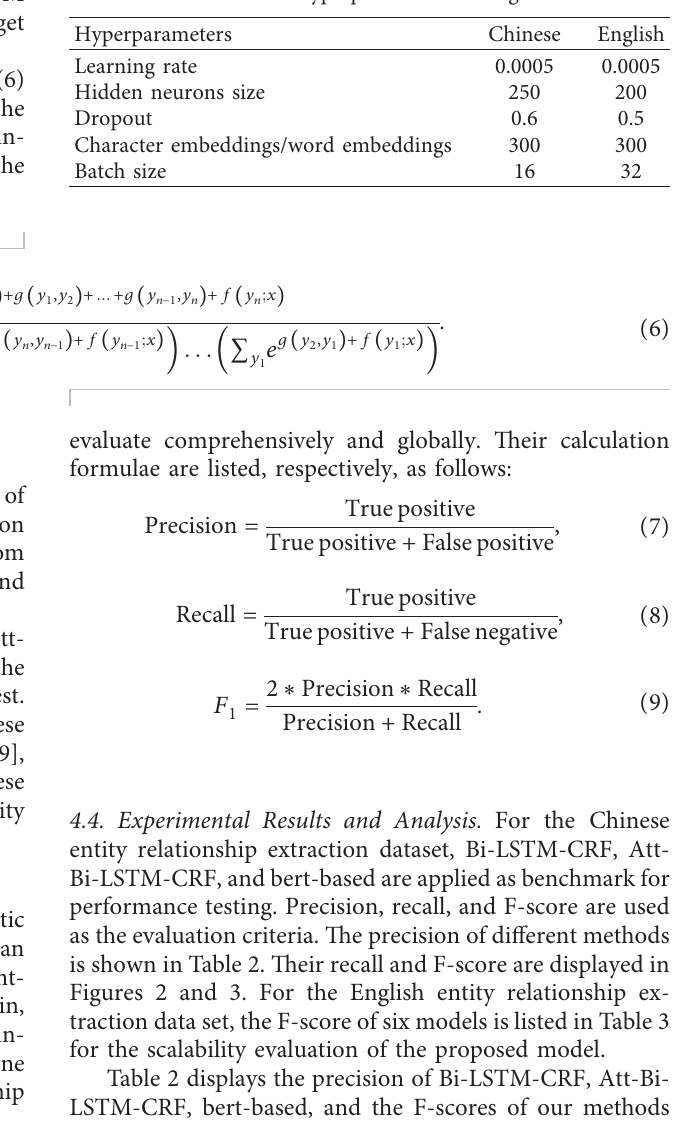
Table 1: Hyperparameters